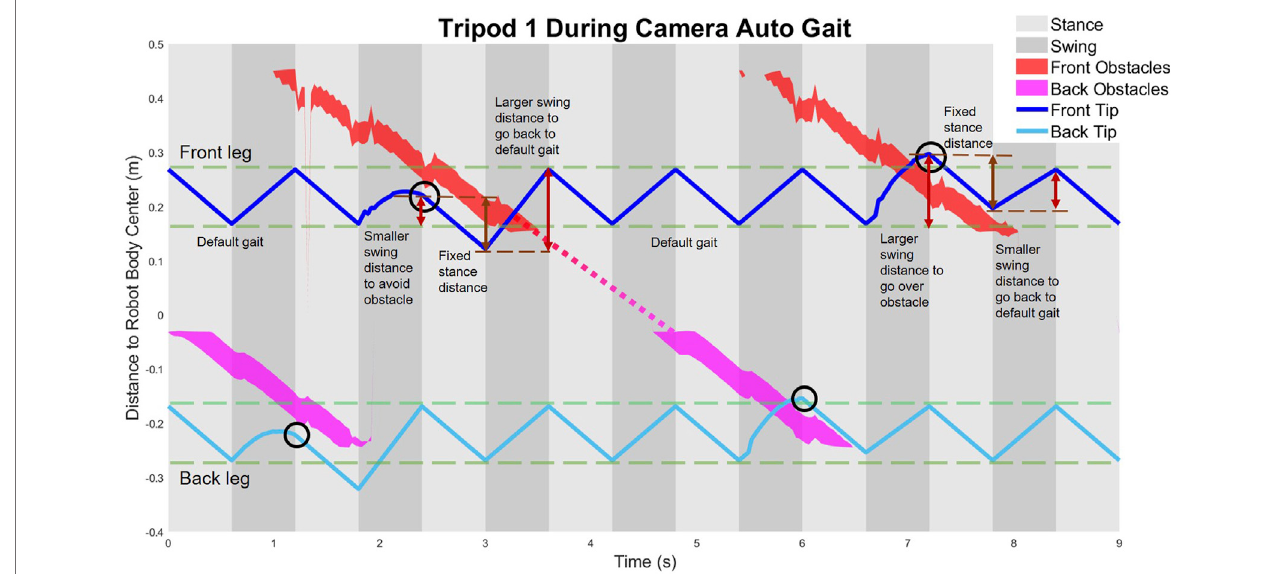
FIGURE 12 | Trajectories of foot tips relative to the robot body in tripod one during camera autonomous gait.